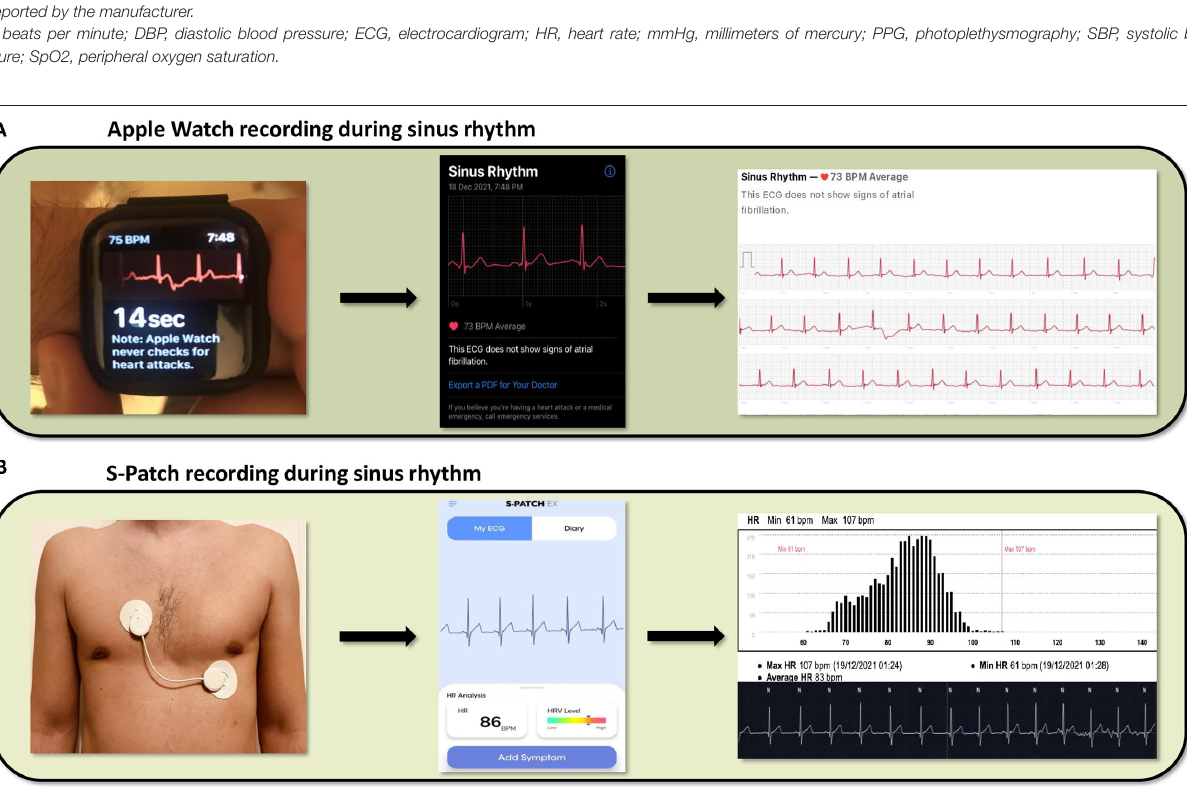
FIGURE 1 | Cardiac rhythm recordings derived from a smartwatch (Apple Watch) and a patch (S-Patch), (A) From left to right, the images show the process of data collection from an Apple Watch, the ECG presentation in the respective smartphone application and the final report, featuring a possible diagnosis, (B) From left to right, the images show the same process captured by the wearable